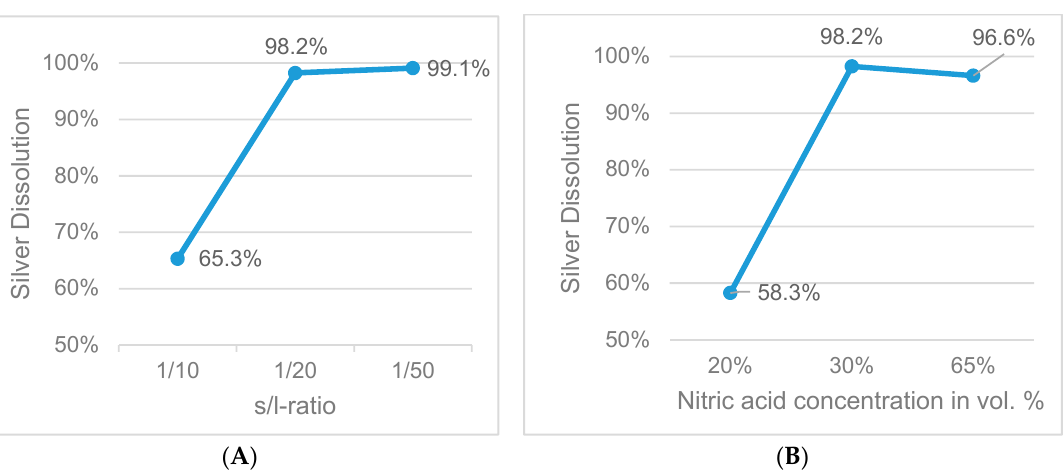
Figure 10. Influence of temperature and leaching duration on silver dissolution (fixed parameters: 30% HNO 3 , s/l = 1/20).